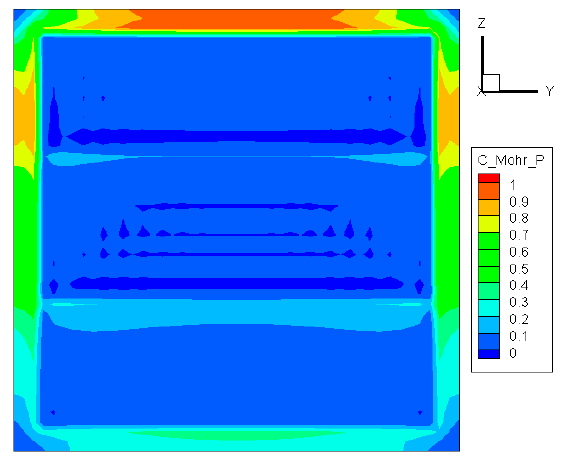
Figure 7. Distribution of